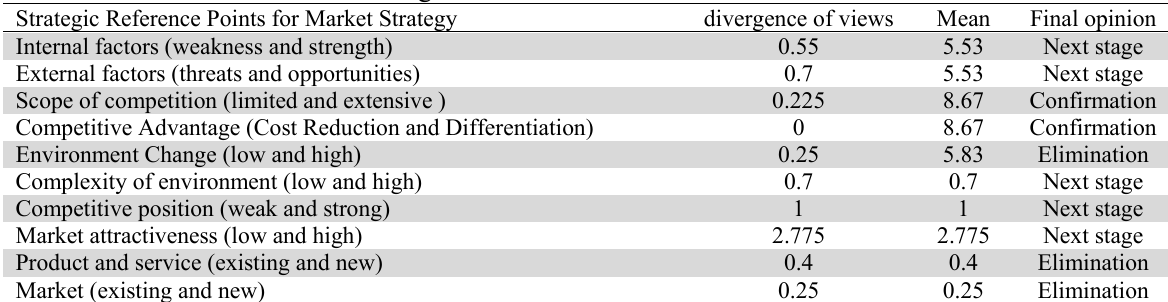
Results obtained from the second stage Strategic Reference Points for Market Strategy divergence of views Internal factors (weakness and strength) External factors (threats and